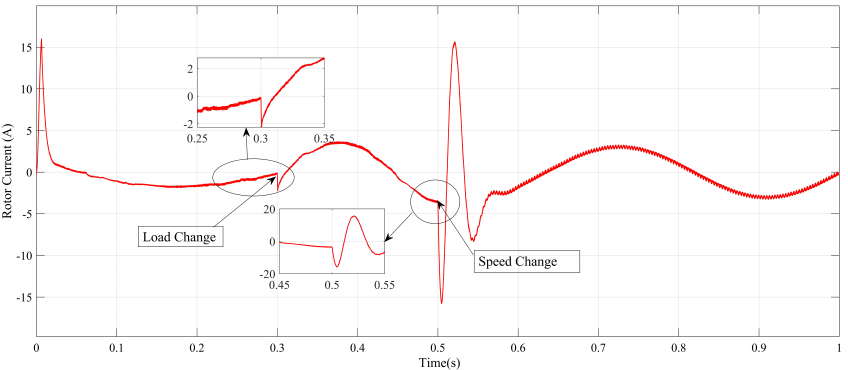
Figure 4. Rotor current response to step change in speed reference and load torque.